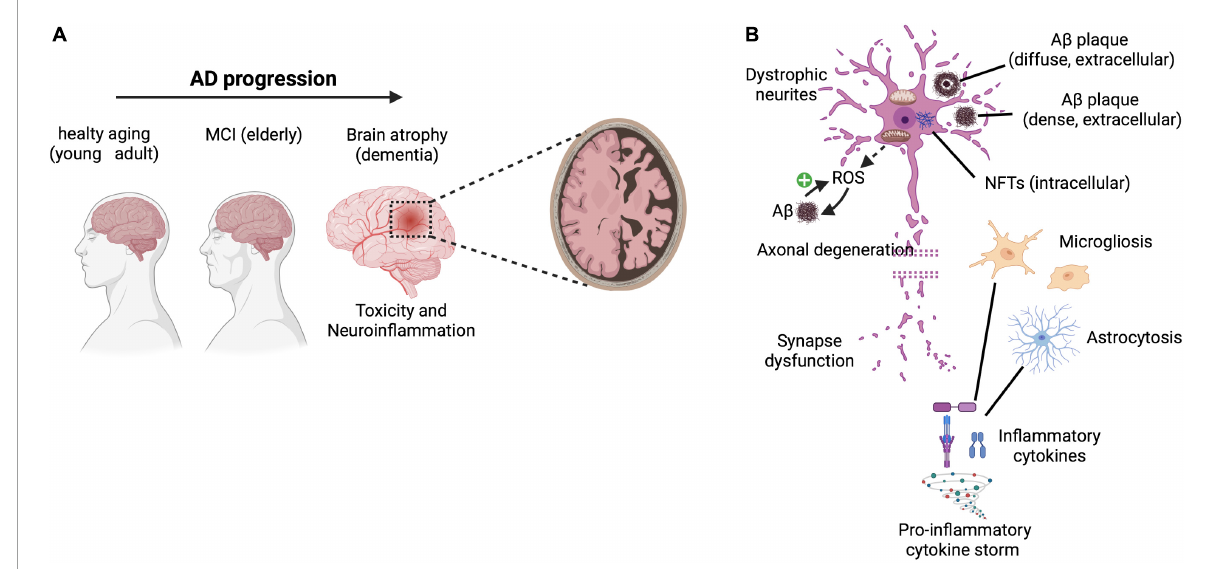
FIGURE1 AD features and hallmarks. (A) Progression of AD from (i) healthy aging in young adults through the appearance of (ii) mild-cognitive-impairment (MCI) in the elderly, toward (iii) clinical AD encompassing dementia, loss of memory and cognitive functions due to brain atrophy (mainly characterized by neurotoxicity and inflammation). (B) The main neuropathological hallmarks include lesions, such as diffuse and dense extracellular amyloid- β (A β ) plaques, intracellular neurofibrillary tangles (NFTs), glial activation and responses (i.e., microgliosis and astrocytosis), release of pro-inflammatory cytokines and mediators as well as oxidative stress (with generation of ROS associated with A β accumulation that in turn may further promote additional ROS production in a positive feedback mechanism), which altogether lead to dystrophic neurites, axonal degeneration, and synapse dysfunction associated with severe neurological impairments. Reactive oxygen species (ROS). Created with